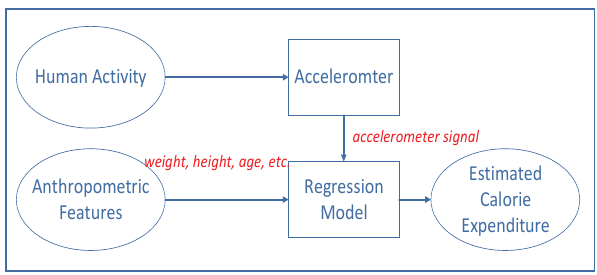
Figure 1: Architecture of the accelerometer based calorie expenditure estimation.